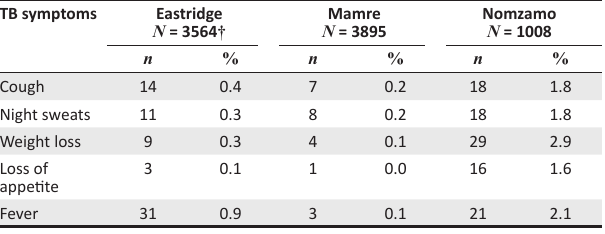
TABLE 3: Proportion of population identified as having tuberculosis symptoms.